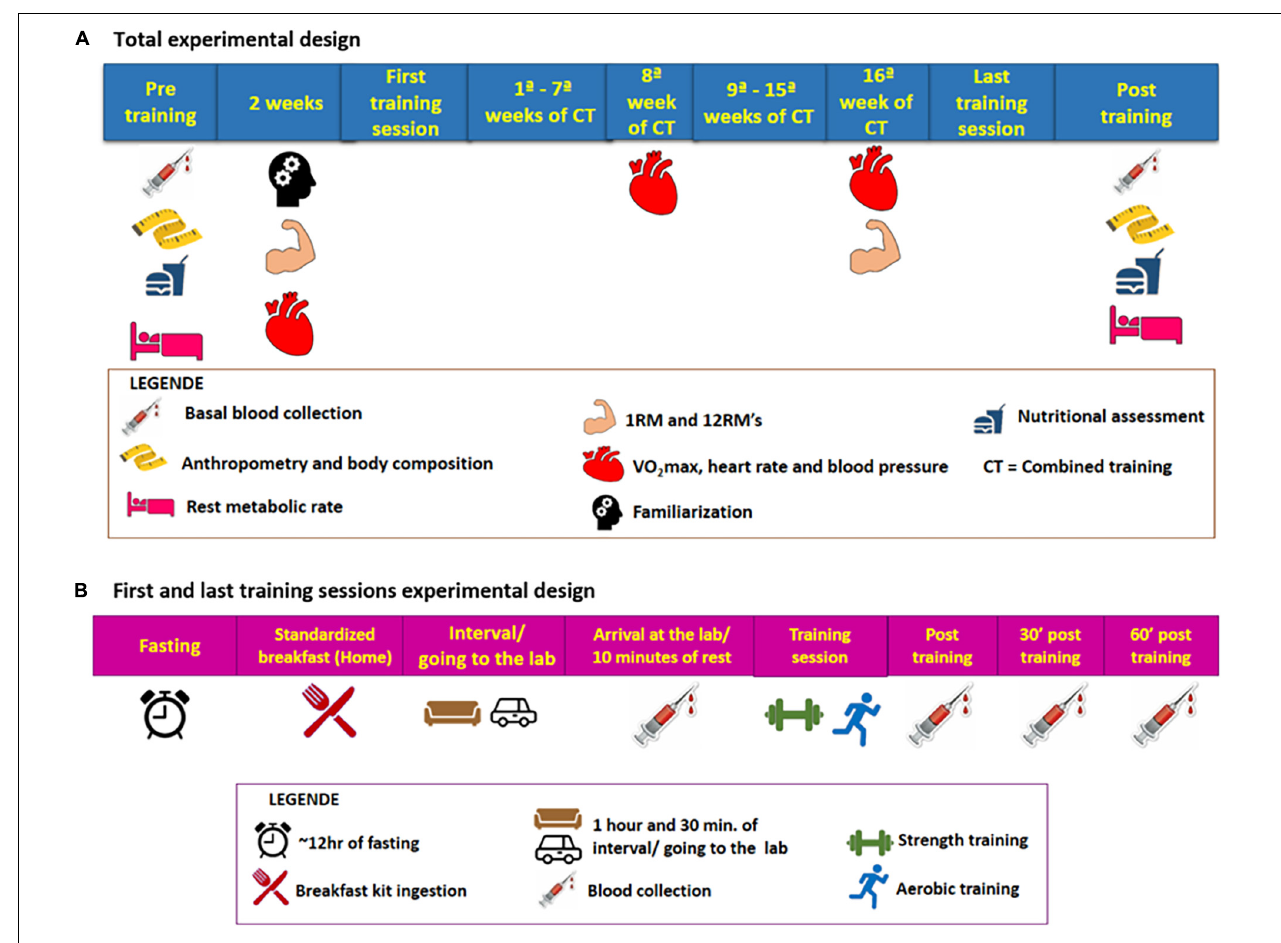
FIGURE 2 | (A) Total experimental design (chronic design). (B) First and last training sessions experimental design (acute